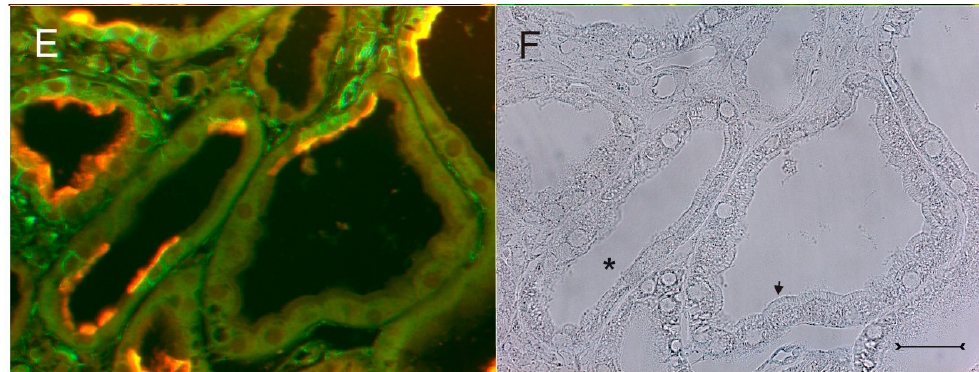
Figure 8. Expression of Kim-1 and vimentin in proximal tubular cysts of the PKD/Mhm (cy/+) rat kidney. ( A , B ) Adjacent sections examined by immunohistochemistry (immunoperoxidase labeling) with staining for Kim-1 ( A ) and vimentin ( B ). Tubular profiles in the middle and right of ( A , B ) show staining (brown deposits) for both proteins in the same epithelial portions of the cysts. In ( B ) (far right), vimentin staining of glomerular cells exhibits the expected pattern. ( C – E ) Fluorescent double labeling with Kim-1 (( C ), red), vimentin (( D ), green); merged view in ( E ); phase contrast image in ( F ). Many of the Kim-1 positive cells also express vimentin (an example is marked by an asterisk in ( F )). The small arrow in ( F ) marks an area of proximal tubular cells with a normal well-expressed brush-border, devoid of any signals. Vimentin is also expressed in interstitial cells (e.g., upper left region in ( D , E )); note: very strong fluorescent signals of Kim-1 are blown-out in ( D ). Bars = 40 µm ( A , B ); 30 µm ( C – F ).